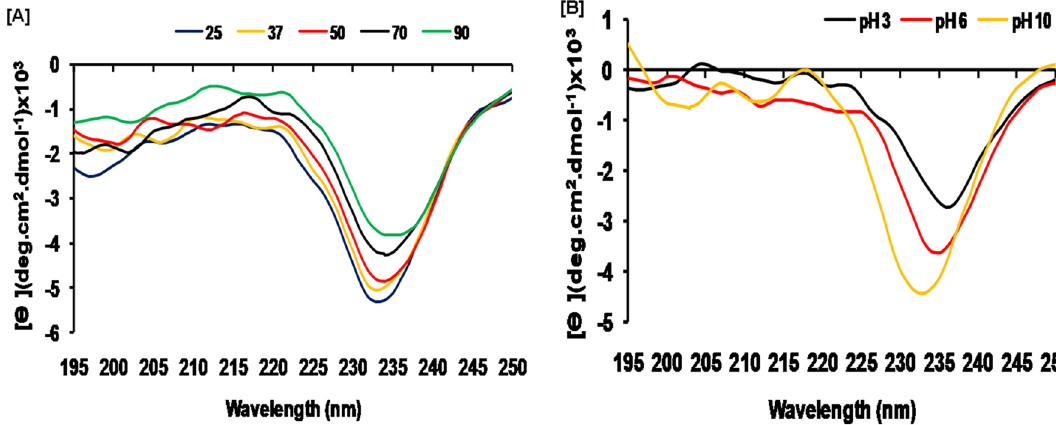
Figure 4. CD studies of SSTI ( A ) Far UV CD spectra (195–250 nm) as function of different temperature incubate for 30 min and ( B ) Different pH incubate for 30